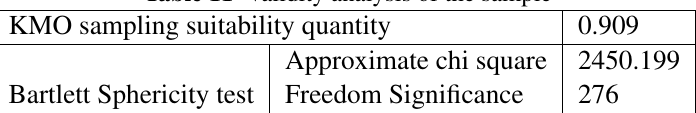
Table 11 Validity analysis of the sample